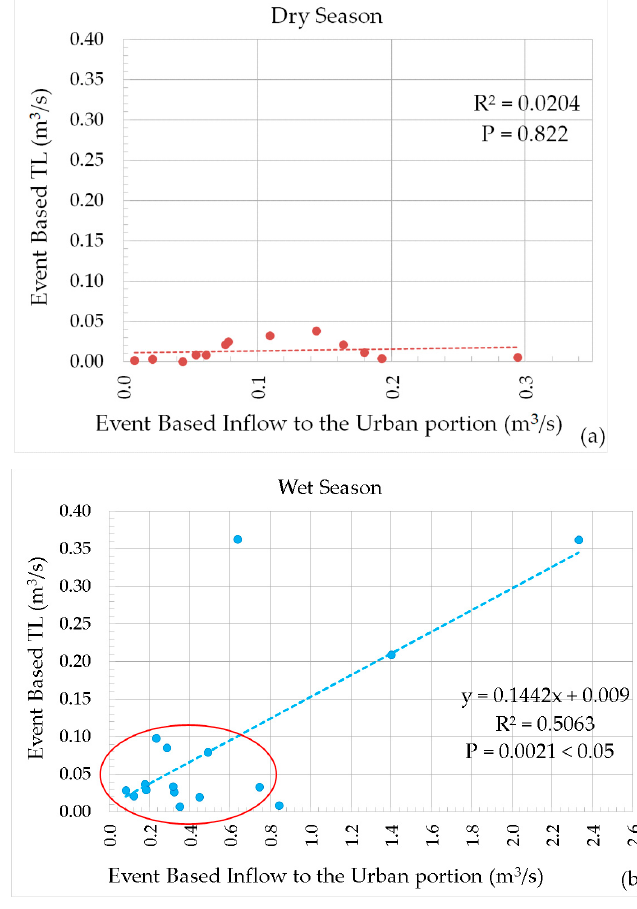
Figure 6. TL and inflow of the urban portion for ( a ) dry season ( b ) wet season .